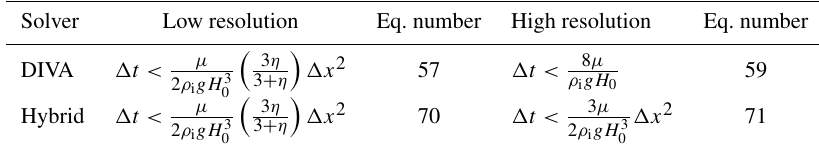
Table 1. Summary of asymptotic time-step limits derived for the DIVA and Hybrid solvers under simplified conditions (1D, uniform viscosity, infinitely long ice slab of uniform thickness H 0 , explicit time-stepping scheme). An analytical solution was not found for the L1L2-SIA solver. Limits are shown for when the advective limit is sufficiently large so as not to apply and are defined loosely for low-resolution and high-resolution regimes. See the text for